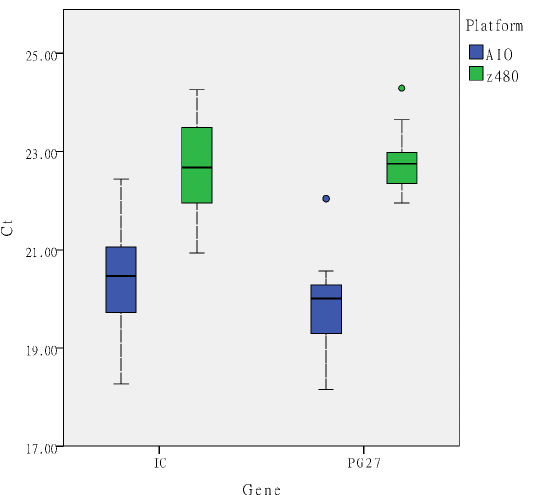
Figure 1. Ct value of the distribution of target genes of Maelstrom TM 8 and LabTurbo TM AIO system when analyzing the clinical samples. Box plots illustrate the median value and interquartile range, and whiskers represent the nearest value to 1.5 times IQR. Outliers are plotted separately. IC (internal control), PG27 (HLA-B*27).